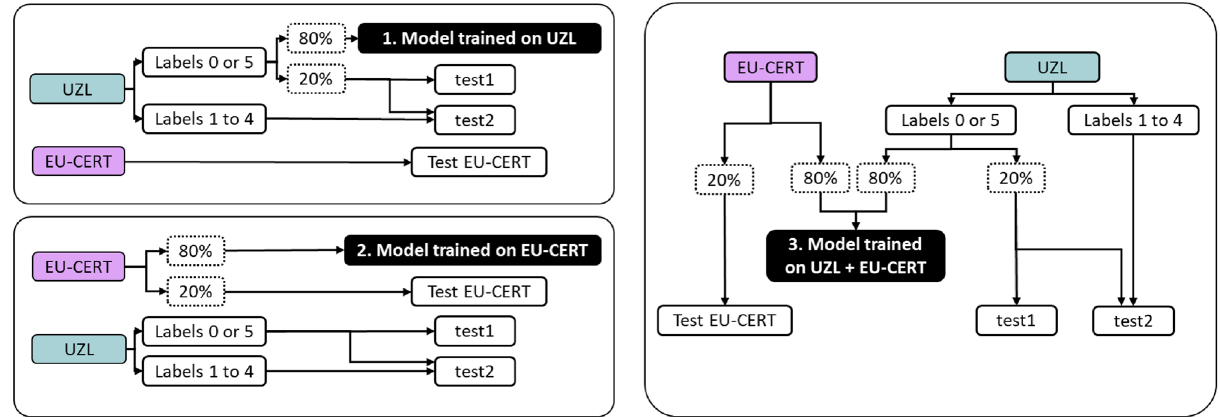
Figure 5. Block diagram describing the training strategies to evaluate the effect of multiple fQRS annotation